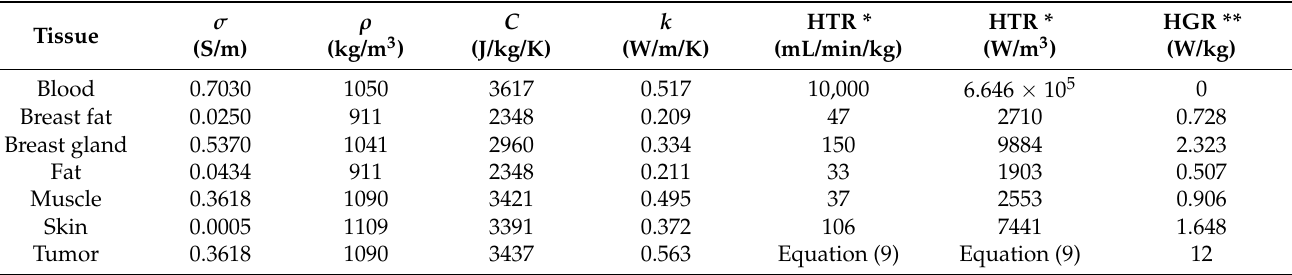
Table 1. Electro-thermal female breast tissue parameters valid for RF ablation treatment with frequency f = 100 kHz [60].